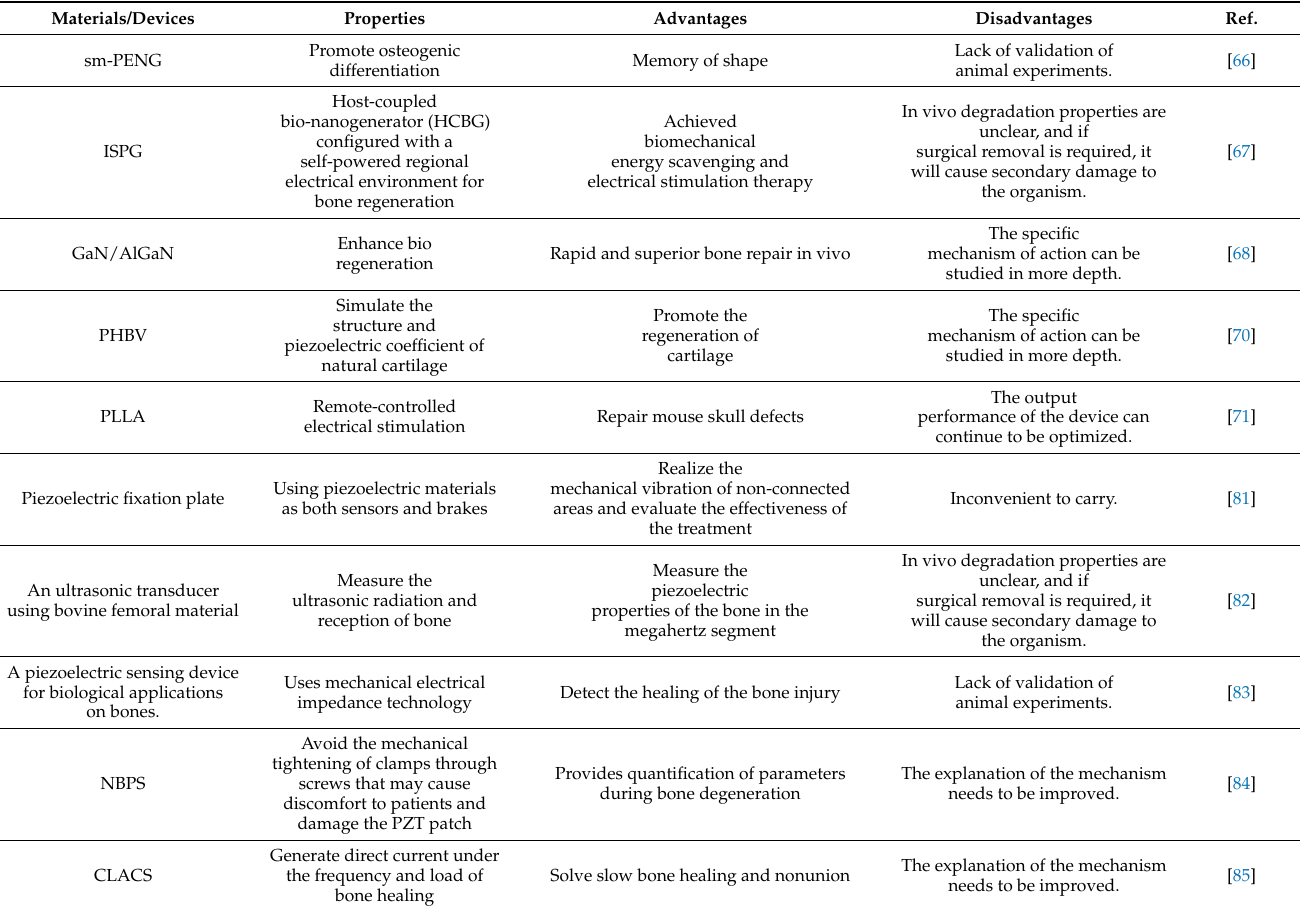
Table 1. Types, properties, and outcomes of piezoelectric material and